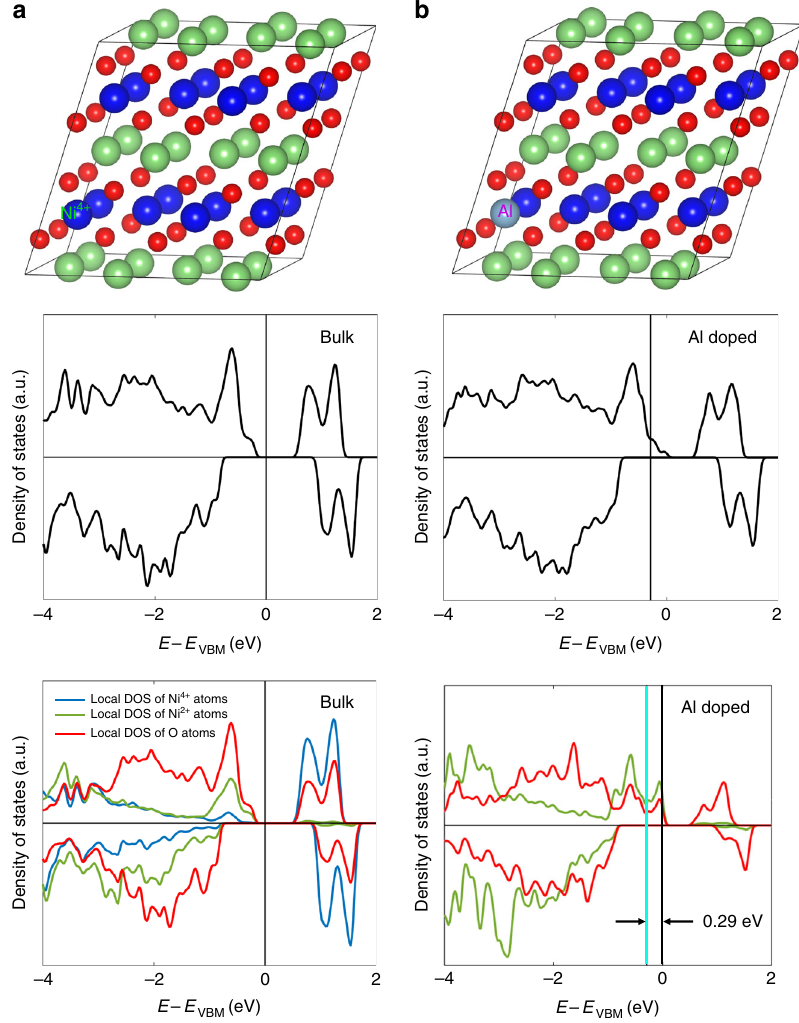
Fig. 7 Al doping effects on the electronic structure of NC. E VBM represents the maximum energy of valence bands of bulk NC. a Upper panel is the atomic model of bulk NC, middle and lower panels represent the total density of state and local density of states of each individual atom, respectively. The blue, green, sliver, and red balls represent the TM, Li, Al, and O atoms, respectively. b Upper panel represents the atomic model of Al-doped NC, in which the Al substitutes the Ni 4 + atoms. Middle and lower panels represent corresponding total density of state and local density of states of each individual atom, respectively. The blue line represents the Fermi level after Al